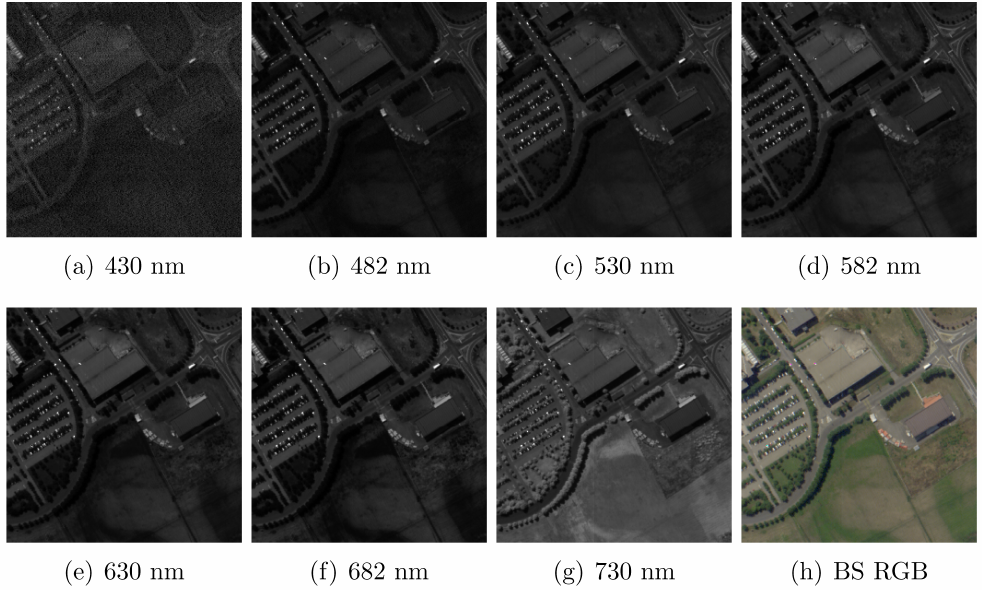
Figure 16. The seven spectral bands of the Pavia University MSI and the correponding band selection (10, 31, and 46) color RGB image for the Pavia University hyperspectral data set (left upper corner).